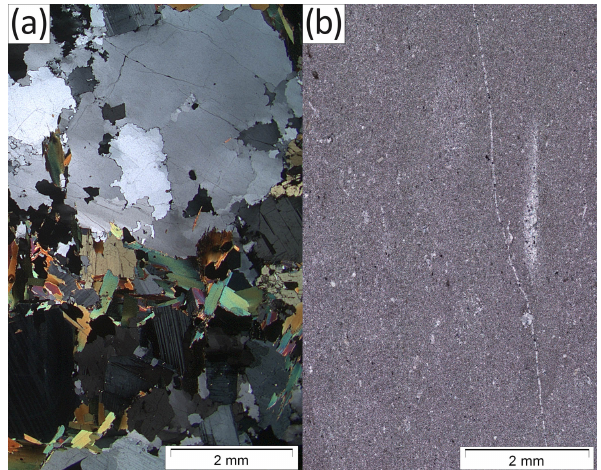
Figure 1. Thin sections of two representative types of rock in crossed polarised light: (a) granite and (b) limestone. The crystal sizes are generally below 4–5mm and a few orders of magnitude smaller in the